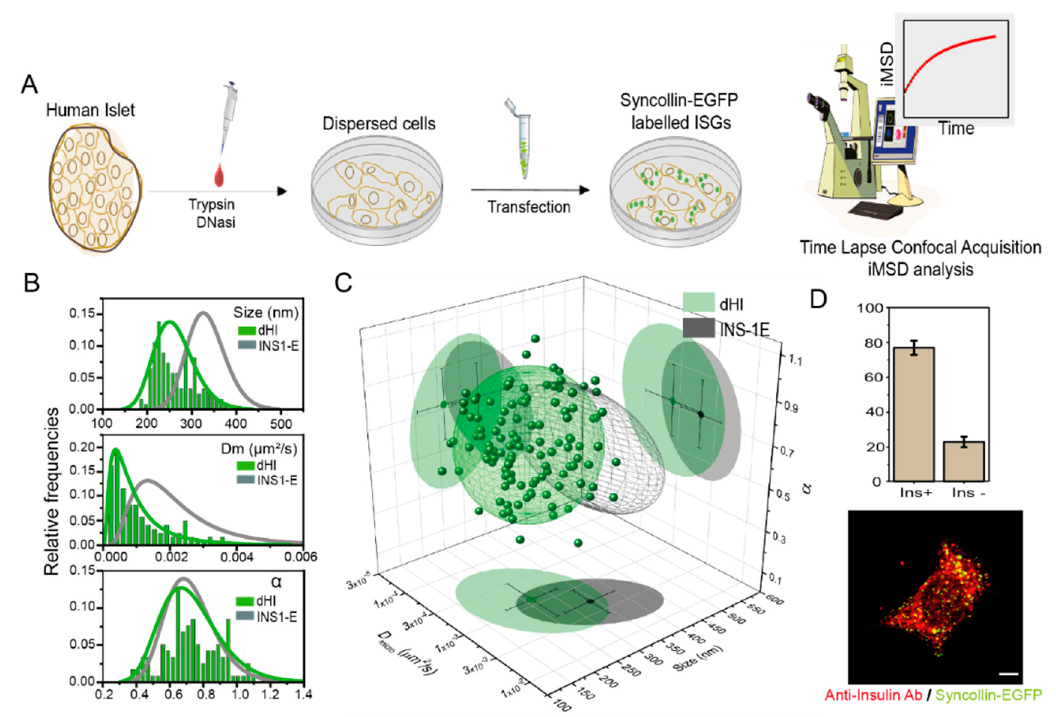
Figure 1. i MSD-based screening of ISGs structural and dynamic properties in dispersed human β -cells, as compared to immortalized INS-1E model. ( A ) Schematic representation of HI dispersion and transfection process. Forty-eight hours post-transfection, fluorescently labeled dispersed cells were observed with a confocal microscope to measure ISG structural- dynamic properties. ( B ) Distributions of the three i MSD relevant parameters (size, D m and α ) of n = 123 dispersed human islet cells (green curve and bars) compared with previous data retrieved from syncollin-EGFP labeled ISGs from INS-1E cells (grey curve and bars) (CIT). ( C ) Three-dimensional parametric plot showing the ‘fingerprint’ of syncollin-EGFP labeled ISGs (represented as 68% confidential ellipsoid) of human dispersed cells (green) and INS-1E (dark grey). ( D ) Exemplary image of a syncollin-EGFP (green) transfected dispersed islet cell immunostained with Alexa-541 Anti-insulin Ab (red). Scale bar: 5 µ m. Column bars show the percentage of insulin-Ab positive (~75%) and Ab-negative in transfected cells (~25%) in n = 3 samples of dispersed human islets.